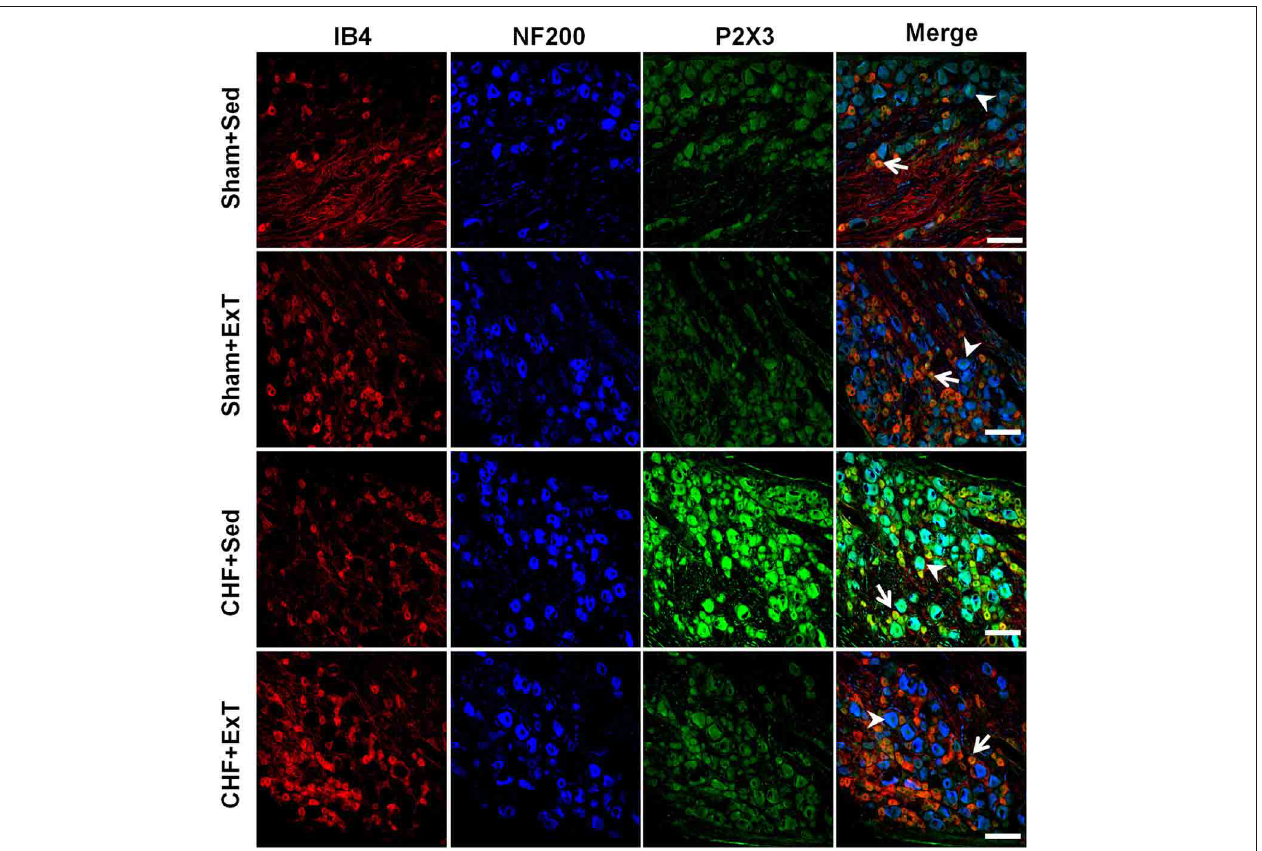
FIGURE 9 | Immunohistochemical data showing the protein expression of P2X3 receptors in L4/L5 dorsal root ganglion (DRG) in Sham + Sed, Sham + ExT, CHF + Sed and CHF + ExT rats. Isolectin B4 (IB4), a C-fiber neuron marker; NF200, an A-fiber neuron marker. White Bar = 100 μ m.